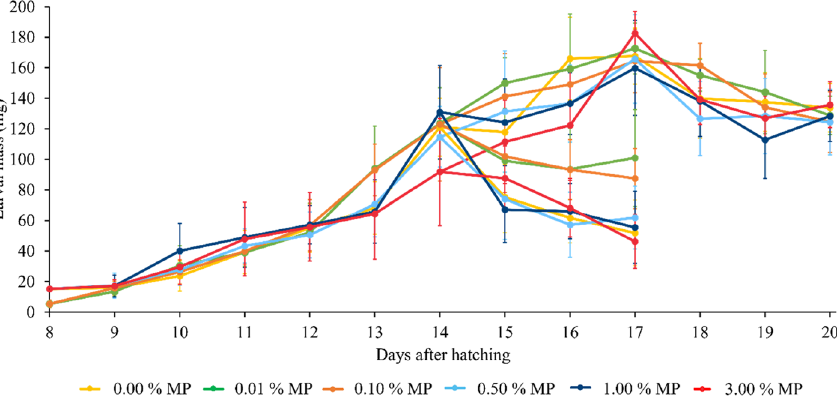
Figure 5. Growth curves of BSF larvae reared on an artificial food waste containing different microplastic contents ( w MP = 0.00, 0.01, 0.10, 0.50, 1.00, 3.00%) of fluorescent blue-labelled polyethylene microplastics (MP). At 14 and 17 DAH starvation started. The results shown are the mean values ( n = 9), while the error bars correspond with their standard